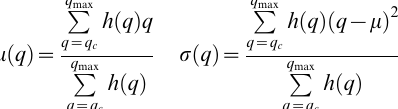
deviation of the mode, calculated in the interval [ q , q max ], given by: